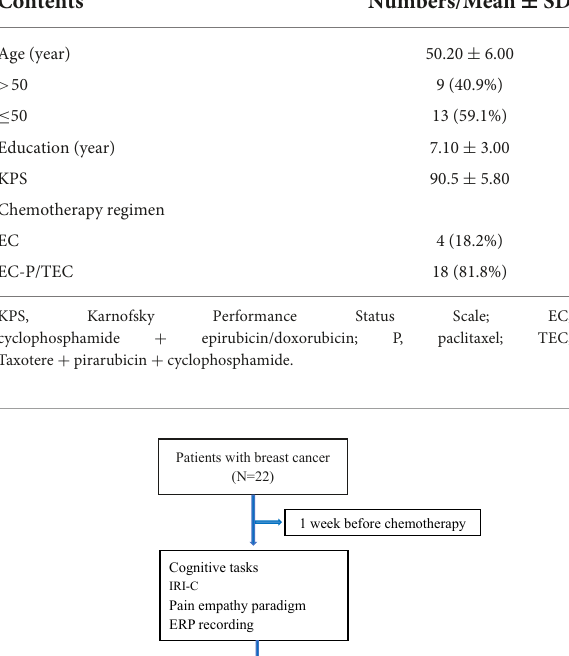
TABLE 1 The basic clinical characteristics.